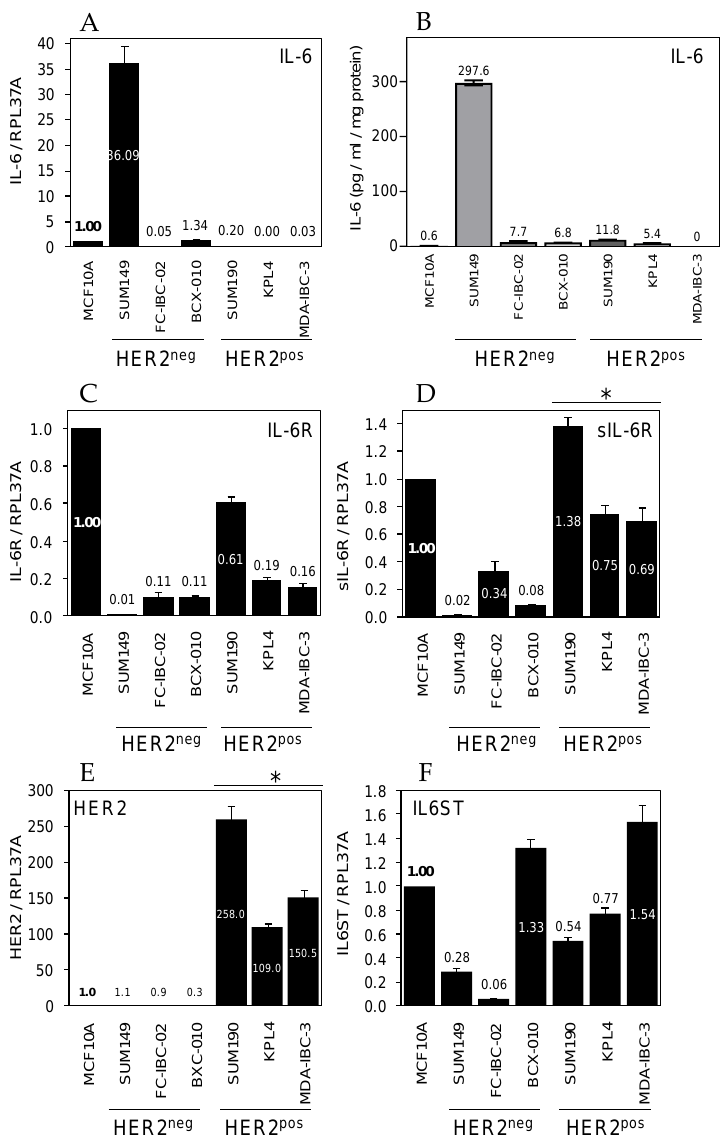
Figure 2. Expression of IL-6 signaling pathway components in human inflammatory breast cancer cell lines Basal mRNA levels of IL-6 ( A ), IL-6R ( C ), soluble IL-6R ( D ), HER2 ( E ), and IL6ST/GP130 ( F ) were evaluated by TaqMan qRT-PCR. Expression in immortal MCF10A mammary epithelial cells was set to 1. Mean ± SD ( n = 3). The three HER2 neg and three HER2 pos cell lines are indicated. IL-6R and sIL-6R mRNA levels were highest in the HER2 pos cell lines. * p < 0.05. ( B ) Basal IL-6 protein levels in conditioned medium from the indicated cell lines were evaluated by ELISA. Mean ± SD ( n = 4).